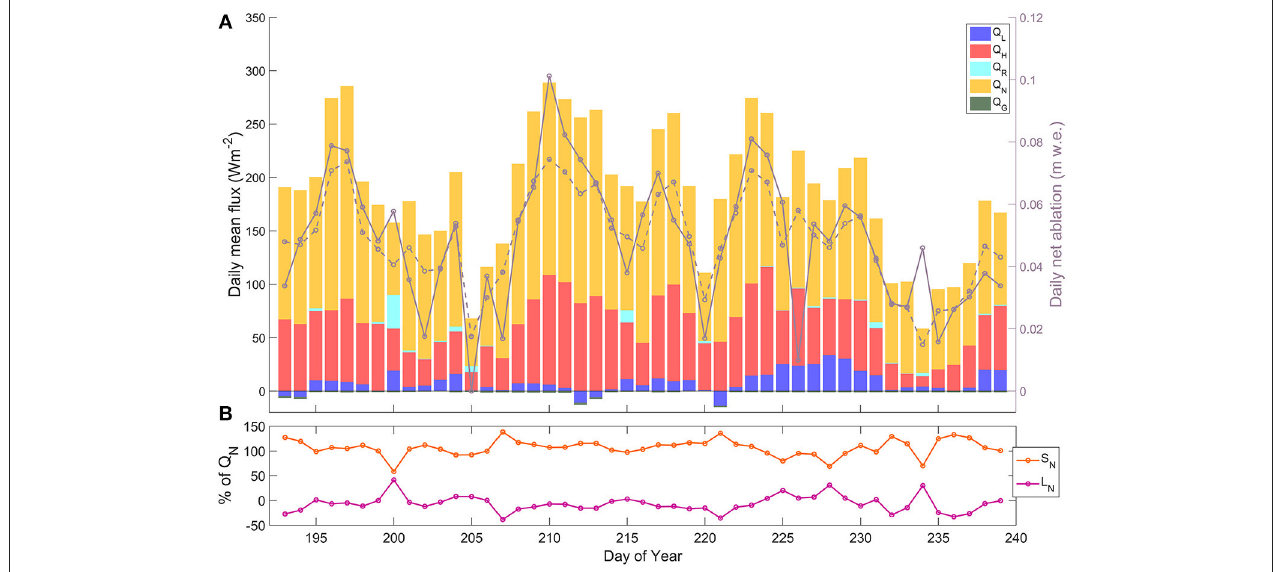
FIGURE 5 | (A) Daily mean energy fluxes, and the daily net observed and modeled ablation (solid and dashed gray lines, respectively), and (B) percentage contribution of net shortwave and longwave radiation ( S N and L N ) to daily Q N .